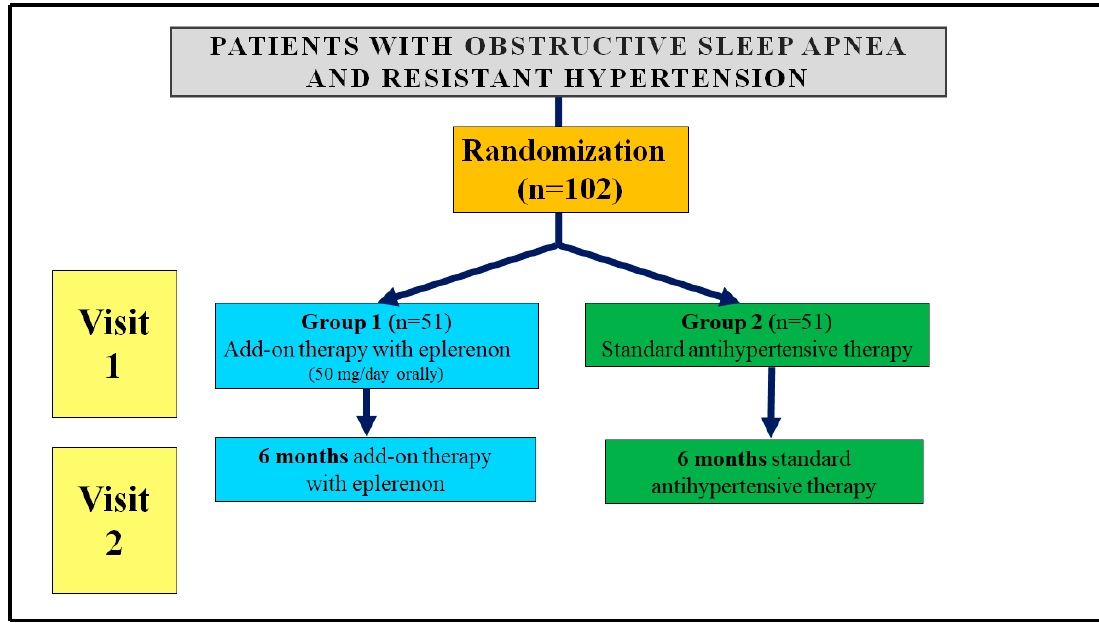
Figure 1. Scheme of the